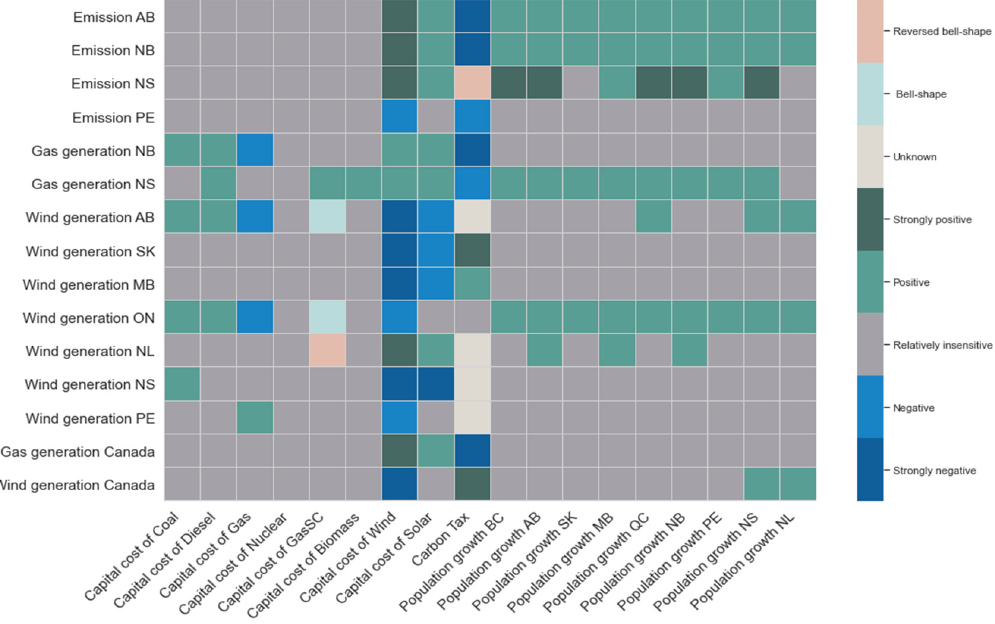
Figure 3. This heat map shows the relationship between the inputs ( x -axis) and outputs ( y -axis) in 2030. It includes only design variables that have variations in the training dataset. The correlations are color-coded based on the shape of input-output correlation plots. The plots are scaled for each output based on the minimum and maximum values, so the relationships depicted in the heat map are relative to the specific output being considered. The heat map provides a visual representation of how each input affects each output and allows for easy identification of the strongest relationships.